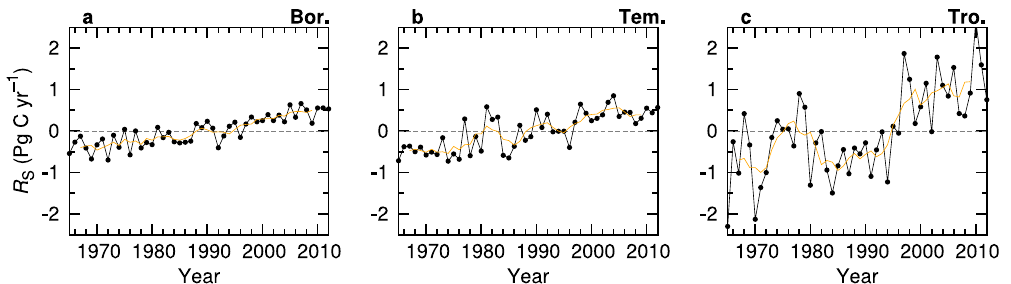
Figure 4. Interannual variations of soil respiration for boreal, temperate, and tropical regions. The orange lines represent the 5-year moving averages.